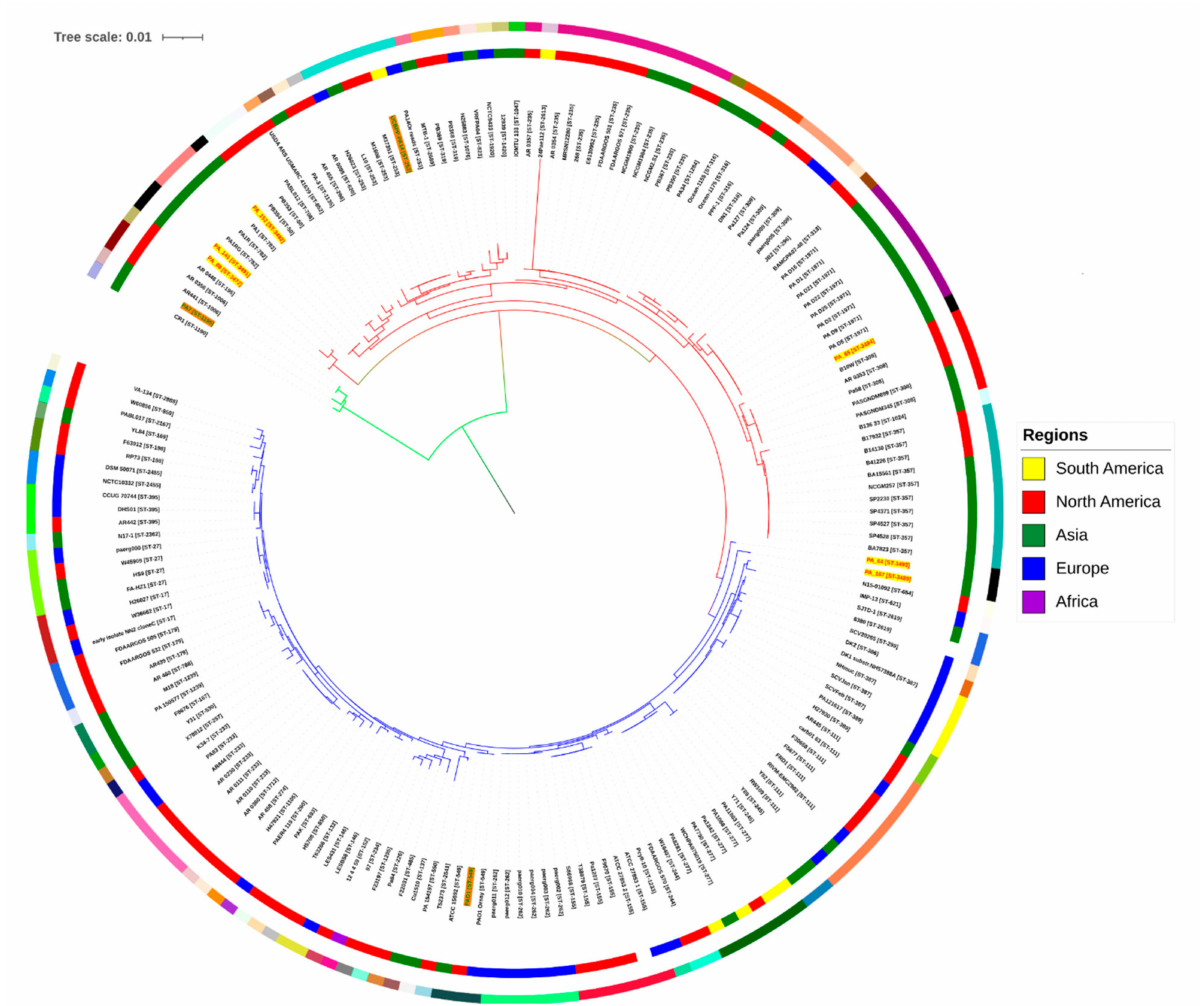
Figure 4. A maximum likelihood tree based on variations in housekeeping genes of 174 global Pseudomonas aeruginosa strains (available at NCBI at the time of analysis, 20 January 2020) and six new sequence type study strains. The inner-colored ring represents the region of isolation of P. aeruginosa strains, while the outermost colored ring represents different sequence types (STs). The tree was refined and annotated using iTOL